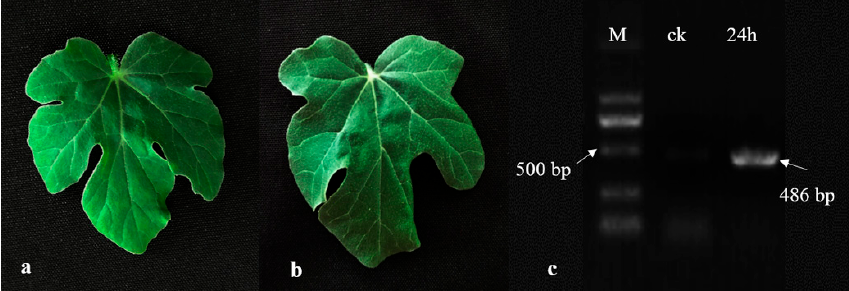
Figure 1. Phenotypes and confirmation of Cucumber green mottle mosaic virus (CGMMV) in watermelon leaves. ( a ) ck watermelon leaf; ( b ) 24-h post-inoculation (24 hpi) watermelon leaf; ( c ) RT-PCR confirmation of CGMMV accumulation in watermelon leaves.